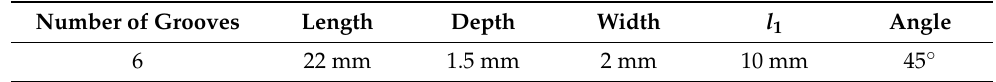
Table 1. Specific parameters of transducer